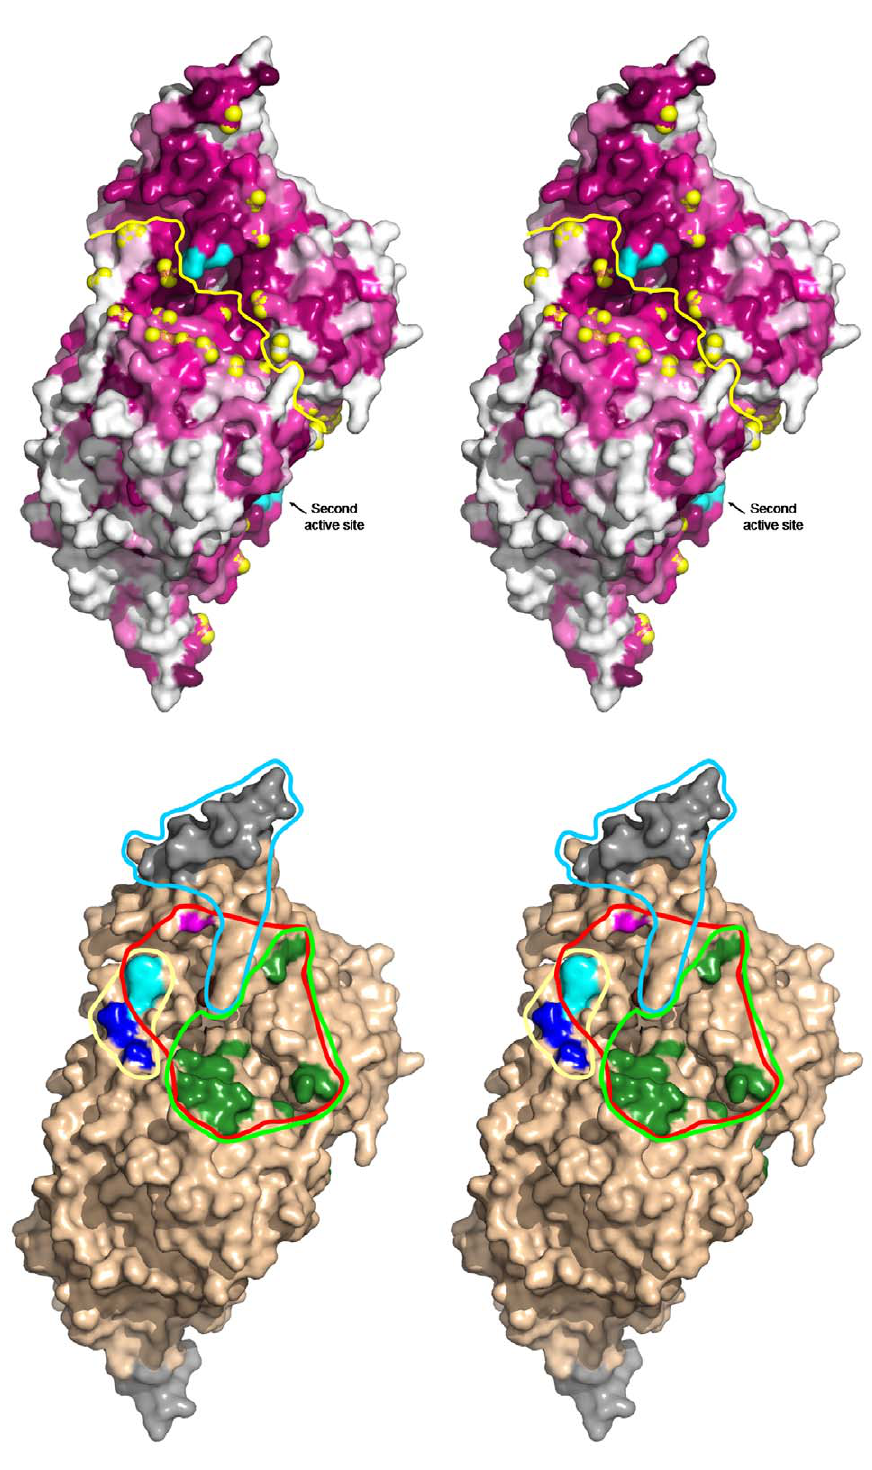
Figure 6. Protein binding surface of the IscS dimer. (A) Residue conservation pattern on the surface of the IscS dimer. The view is toward the active site Cys328. The yellow line indicates the dimer interface and the yellow spheres mark the tips of the residues that have been mutated. The level of conservation of surface residues is marked in shades of burgundy (dark, high conservation; white, highly variable). The residues Cys328- Ser336 are colored cyan. (B) location of mutations affecting interaction with acceptor proteins: IscU, gray; TusA, blue; ThiI, in magenta; TusA/ThiI, cyan; CyaY/IscX/ThiI, dark green. The C-terminal residues 376–404 colored gray at the top-right are missing in the D 376–404 deletion mutant. The footprint of IscU is marked by light blue line: TusA, yellow line; ThiI, red line; and IscX, CyaY, green line.